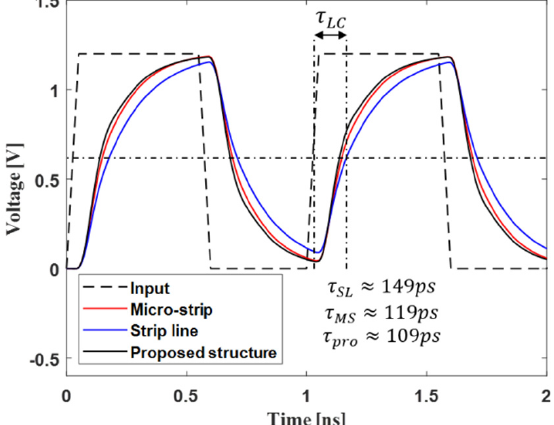
Figure 13. Timing analysis of proposed channel structure and conventional channel structure.